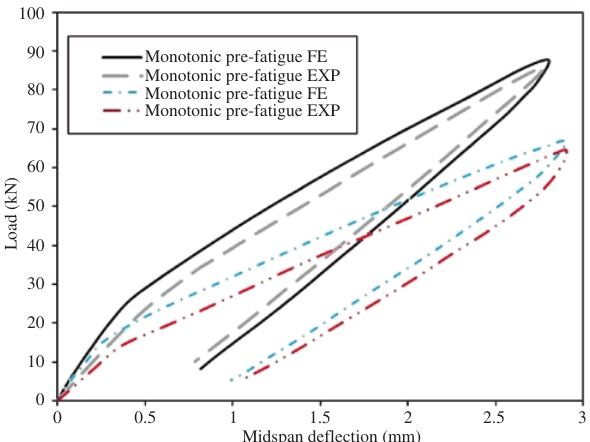
Figure 8: Pre-fatigue monotonic load-deflection curves of RC and CFRP-retrofitted RC specimens, as determined by FE and experimen- tal